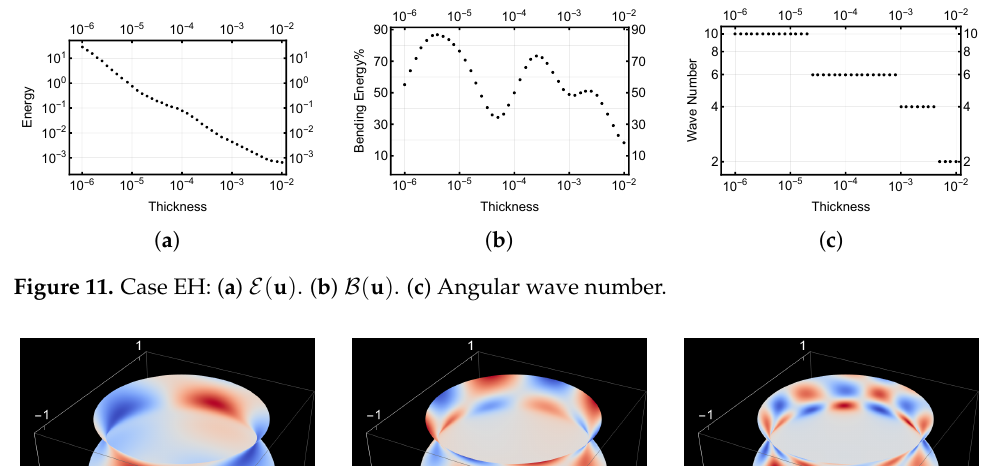
Figure 10. Case PEHP: ( a ) E ( u ) . ( b ) B ( u ) . ( c ) Angular wave number.